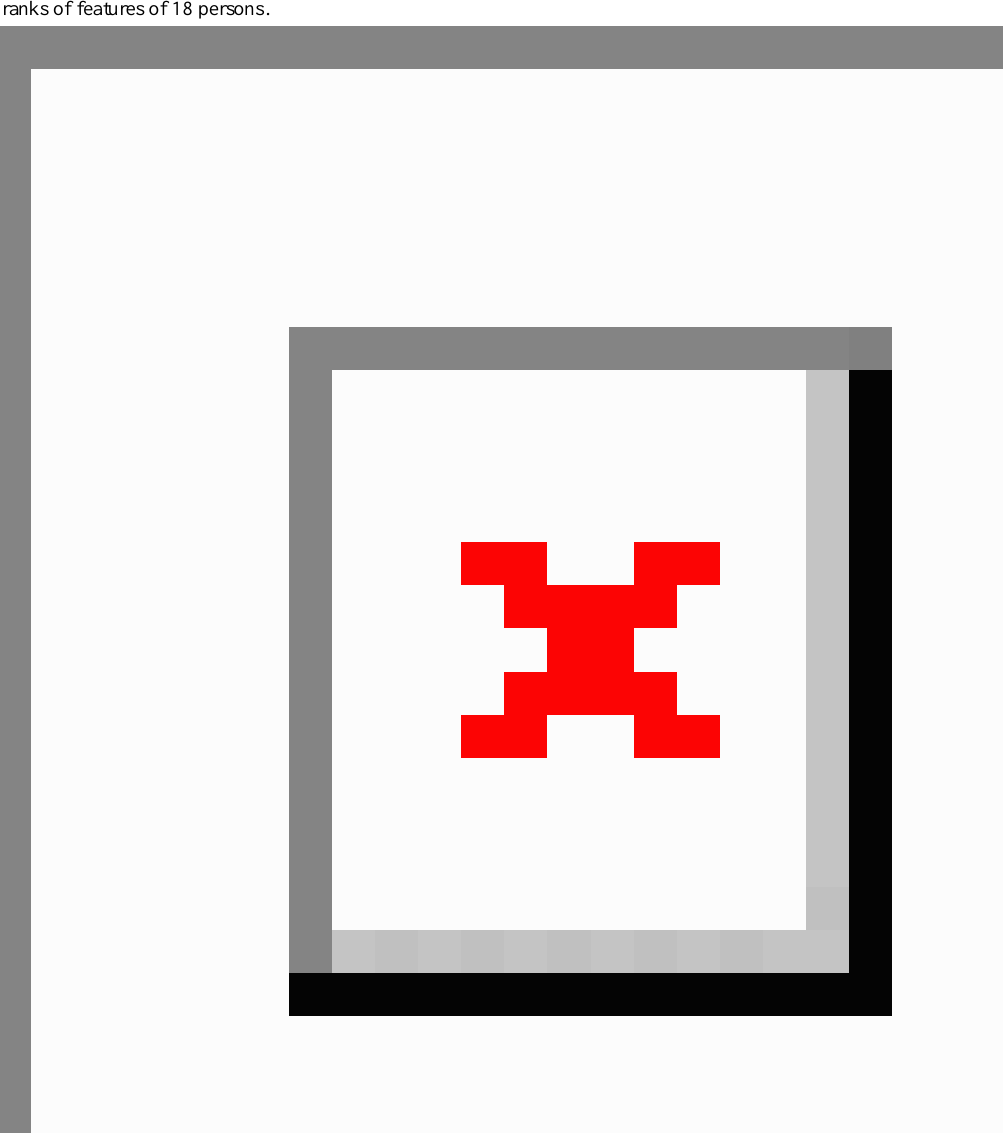
Figure 6. Importance of feature categories for emotional state detection. The color-coded portions of each category represent their contributions to the top 3 ranks of features of 18